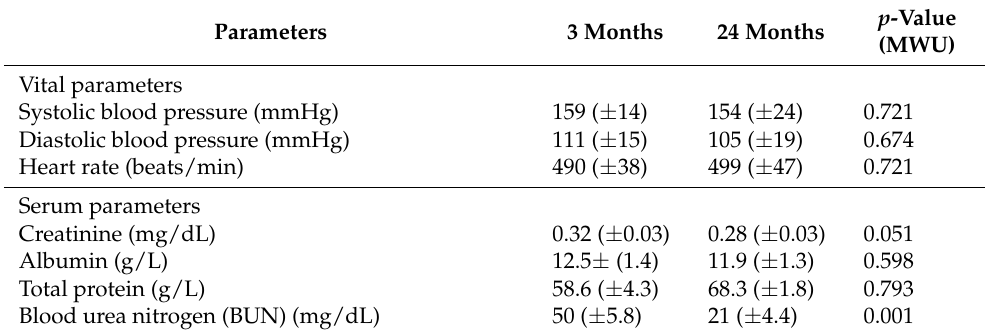
Table 1. Male Sprague Dawley Rats’ characteristics at 3 and 24 months of